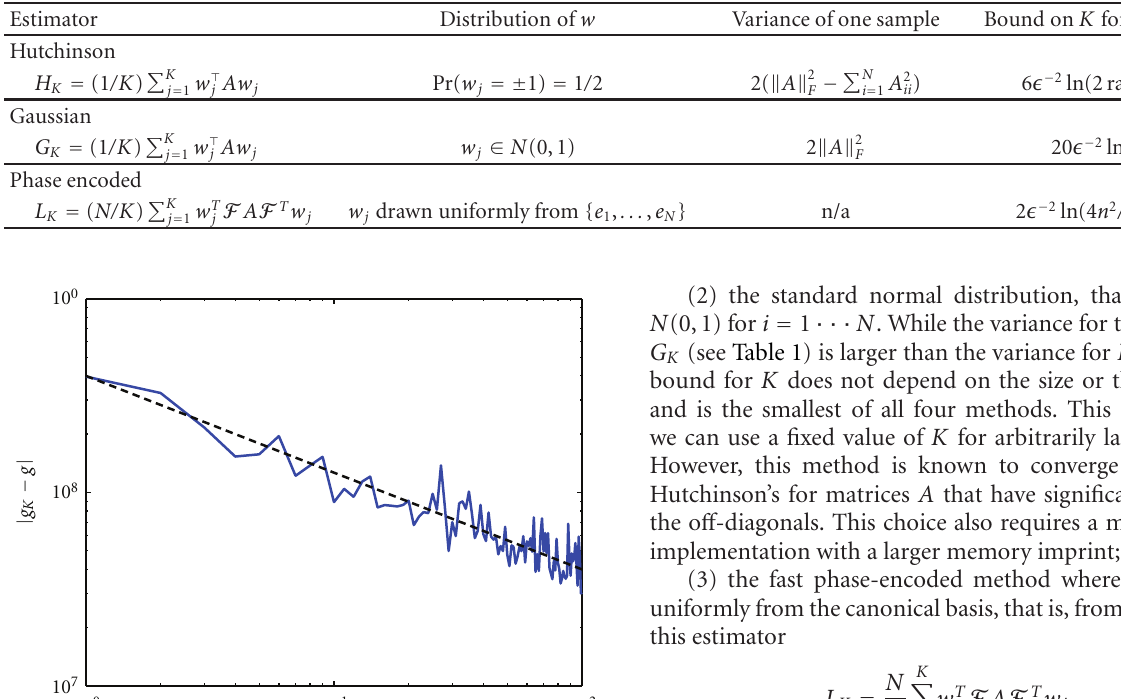
Table 1: Summary of bounds, adapted from Avron and Toledo [14].